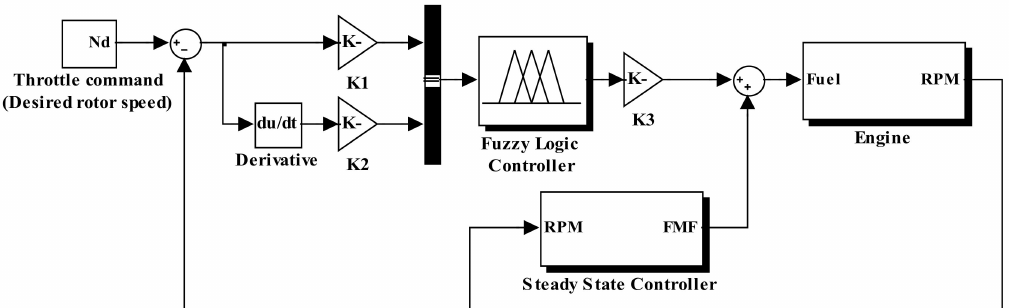
Figure 2. Schematic of pure fuzzy controller (PFC).